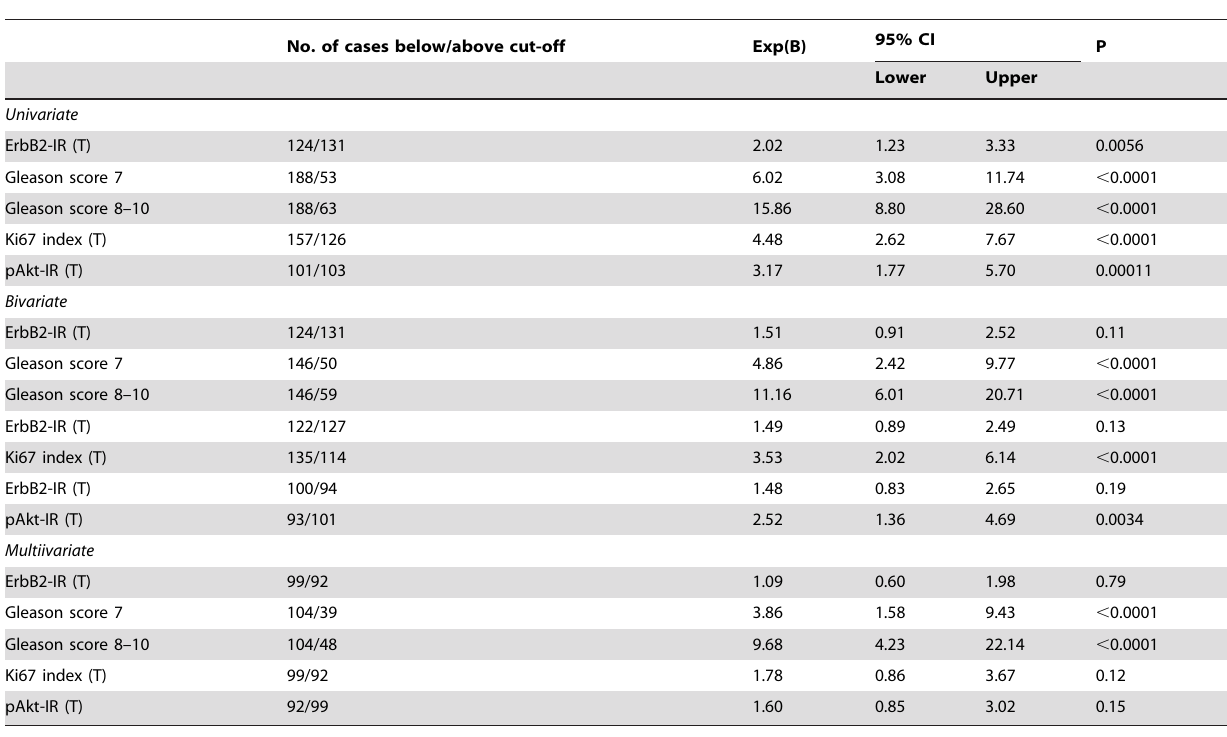
Table 4. Cox proportional hazards regression analyses for tumour ErbB2-IR in cases followed by expectancy after diagnosis.